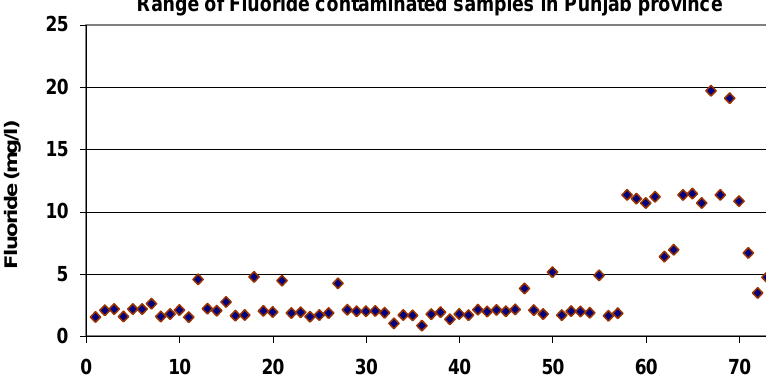
Figure-3: Range of fluoride contaminated samples (>1.5mg/l) in Punjab Province Figure 3. Range of fluoride-contaminated samples ( > 1.5mgL − 1 ) in Punjab